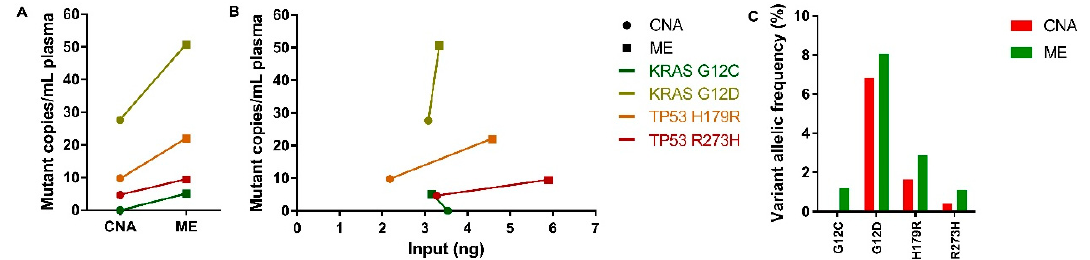
Figure 6. Mutation detection among the CNA and ME extraction methods in DLA samples. ( A ) Before-after plot illustrating the number of mutant copies per mL of plasma for four paired CNA-extracted (dots) and ME-extracted (squares) samples. ( B ) XY plot illustrating the detected mutant copies per mL of plasma plotted against the input in ng on the x-axis. Similarly colored results originate from the same patient harboring a detectable mutation according to the legend. ( C ) Bar graph illustrating the detected VAF in a percentage of four paired CNA-extracted (red) and ME-extracted (green) samples.